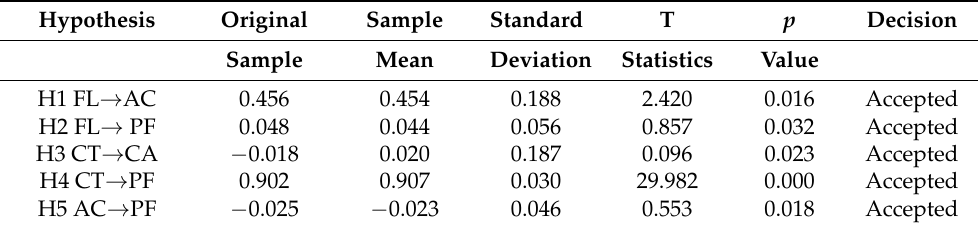
Table 4. Hypothesis